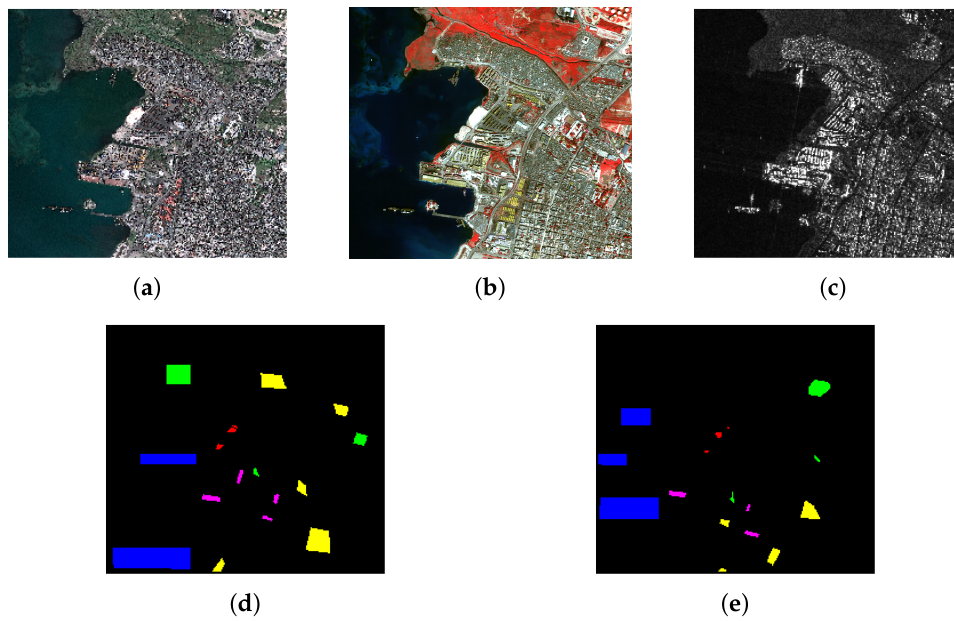
Figure 5. “Haiti” dataset: ( a ) 1.25 m resolution GeoEye-1 image (RGB true color composition), ( b ) 2.5 m resolution QuickBird image (RGB false color composition), ( c ) 5 m resolution synthetic aperture radar (SAR) COSMO-SkyMed stripmap image, ( d ) training map, and ( e ) test map. Color legend for the classes: containers , vegetation , asphalt , buildings , water .